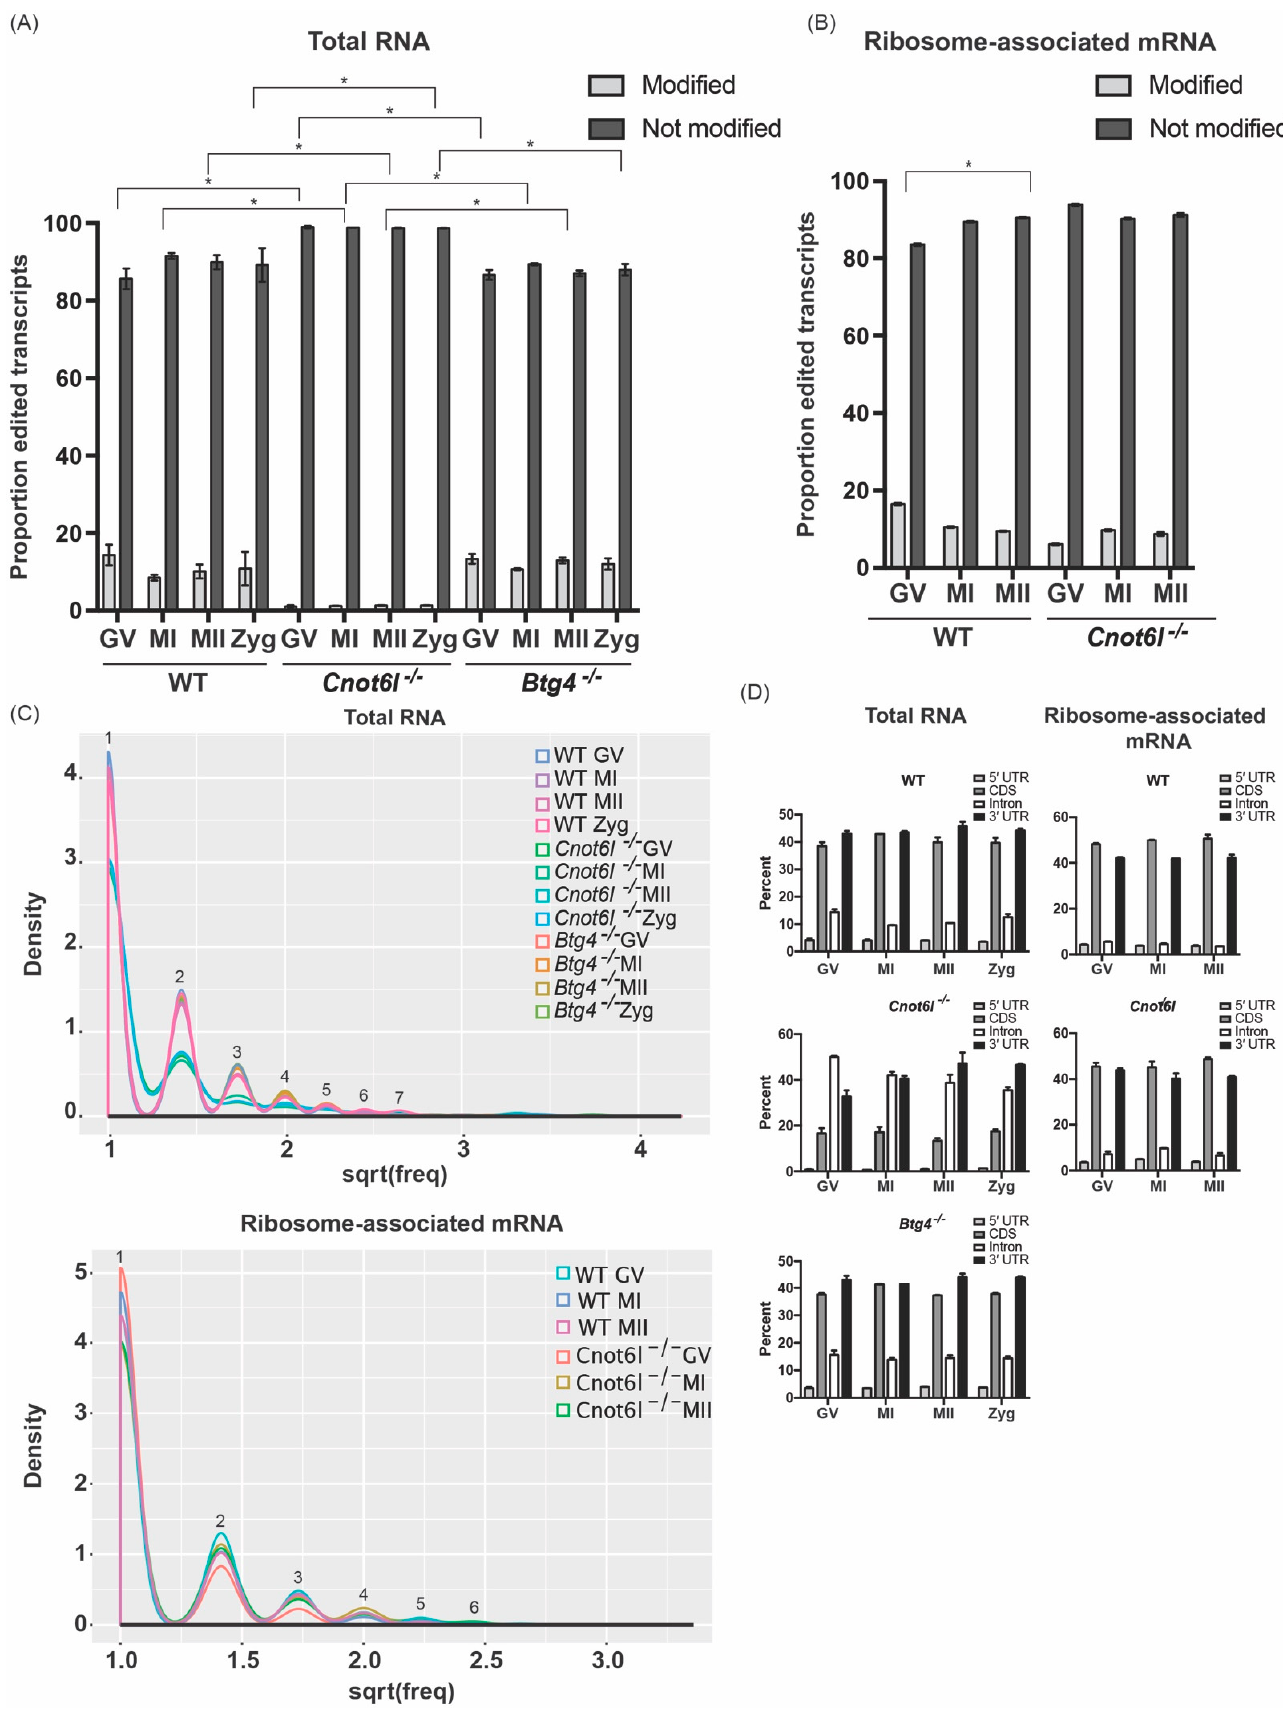
Figure 2. Distinct pattern of inosine RNA modifications from WT, Cnot6l -/- , and Btg4 -/- oocytes, eggs, and zygotes. ( A , B